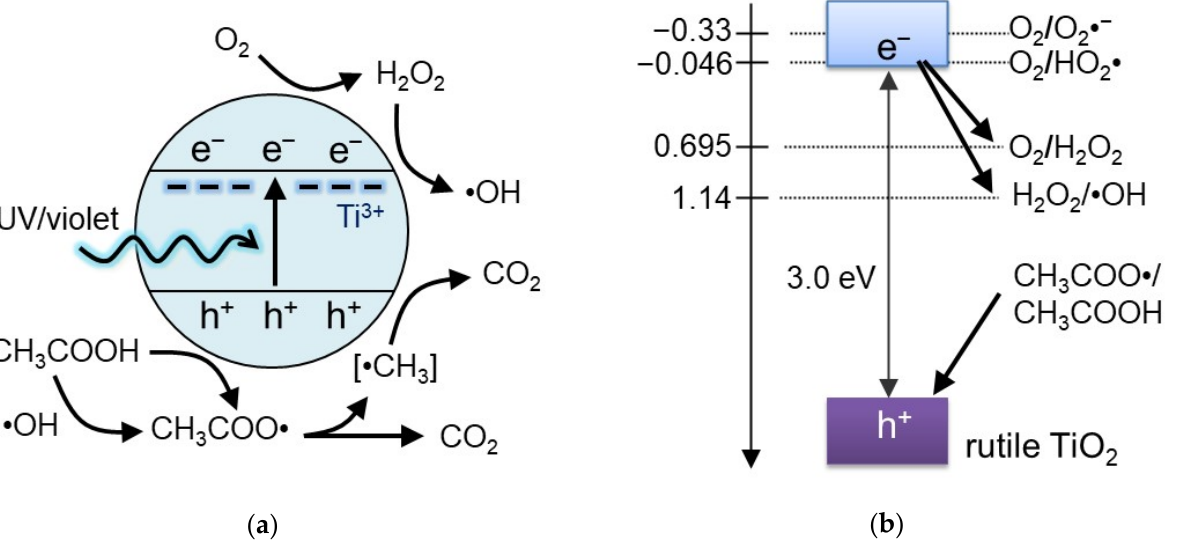
Figure 8. Schematic of the ( a ) proposed reaction mechanism and ( b ) energy diagram for oxidative decomposition of acetic acid by Ti 3+ -rich rutile TiO 2 photocatalysis.